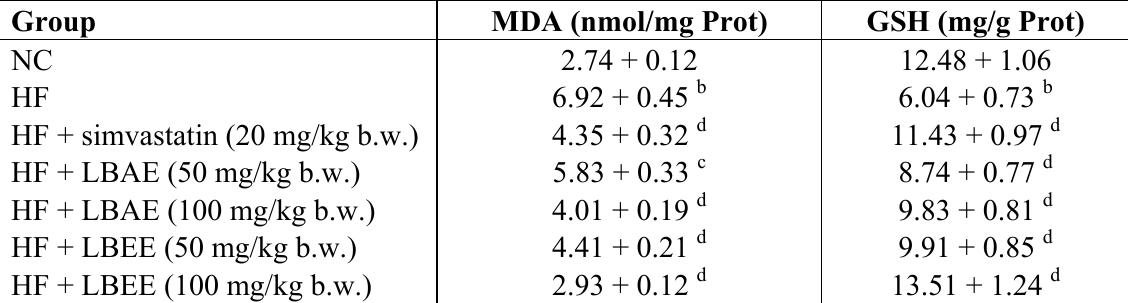
Table 4. Effect of LBAE and LBEE on liver MDA and GSH levels in